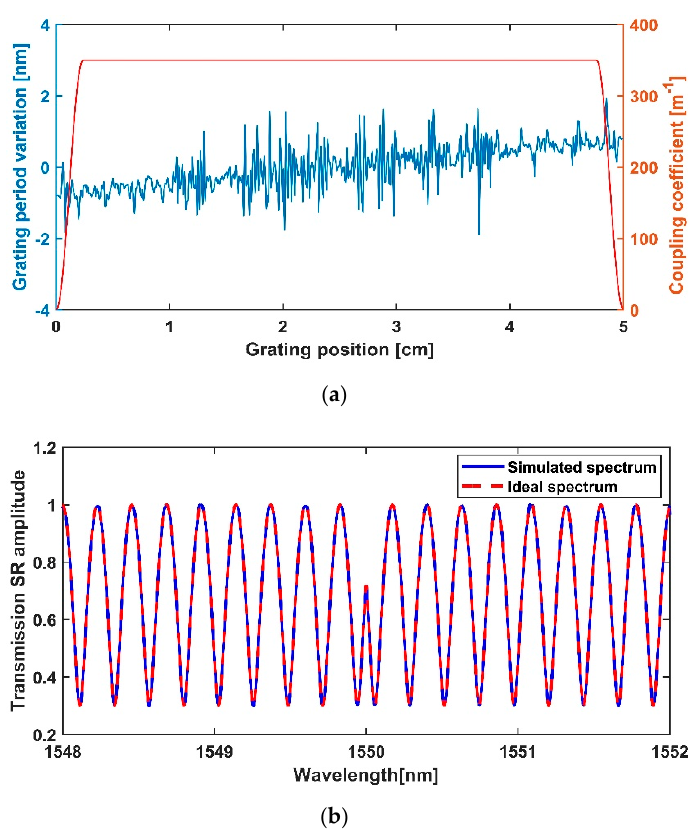
Figure 3. ( a ) Grating period (blue line) and coupling coefficient (red line) of the designed first-order PHT and ( b ) comparison between ideal spectrum (dashed red line) and simulated spectrum (blue line).